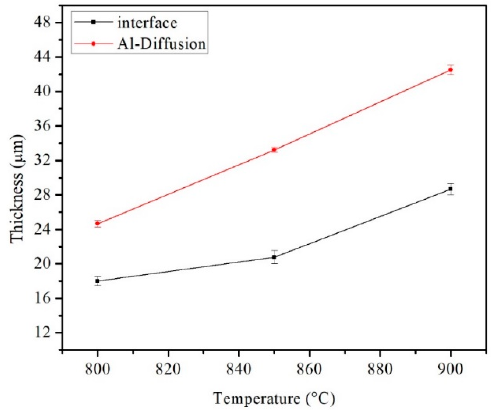
Figure 3. Average thickness of the Al-diffusion layer and the interface including scattering bars, as a function of processing temperature (constant pressure of 15 MPa and time of 7200 s).